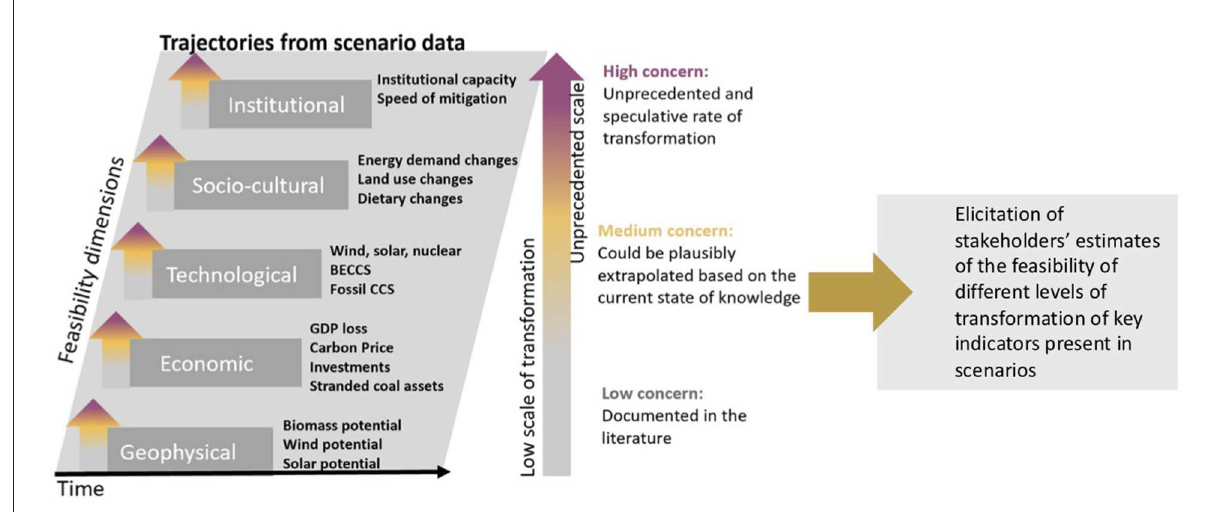
FIGURE3 A summary of the multidimensional feasibility concept (Brutschin et al., 2021).